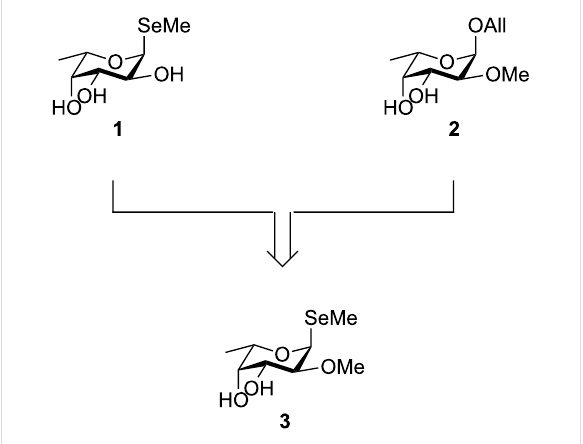
Figure 1: Alkylseleno glycosides, such as 1 , are used as tools for X-ray crystallography of lectins. Some lectins require O -alkylation for carbohydrate recognition, e.g., the fungal Lb-Tec2 binds to 2- O -methyl fucoside 2 . The heavy-atom probe 3 bearing the required O -methyla- tion in position 2 could solve the phase problem for Lb-Tec2 structure